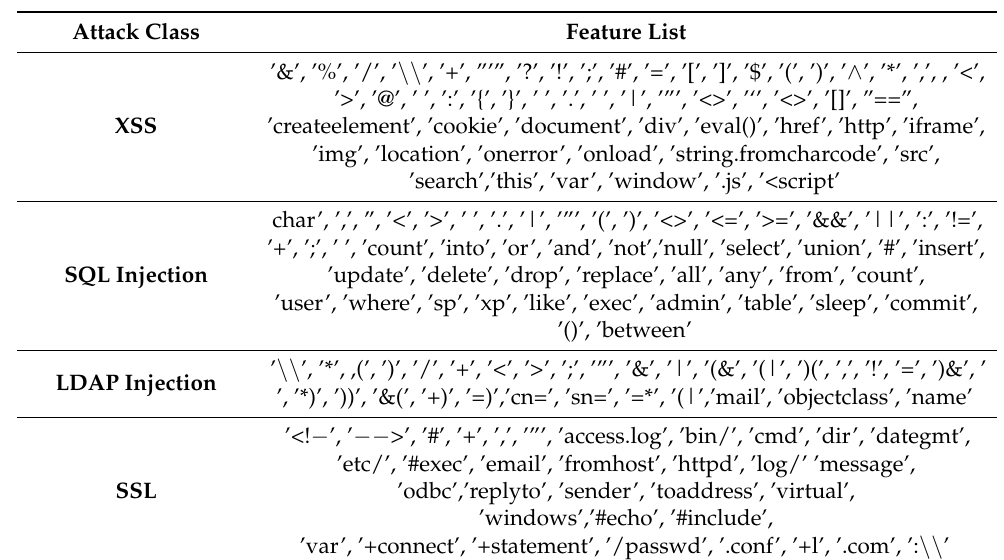
Table 1. Example of features by the security specialist [44].